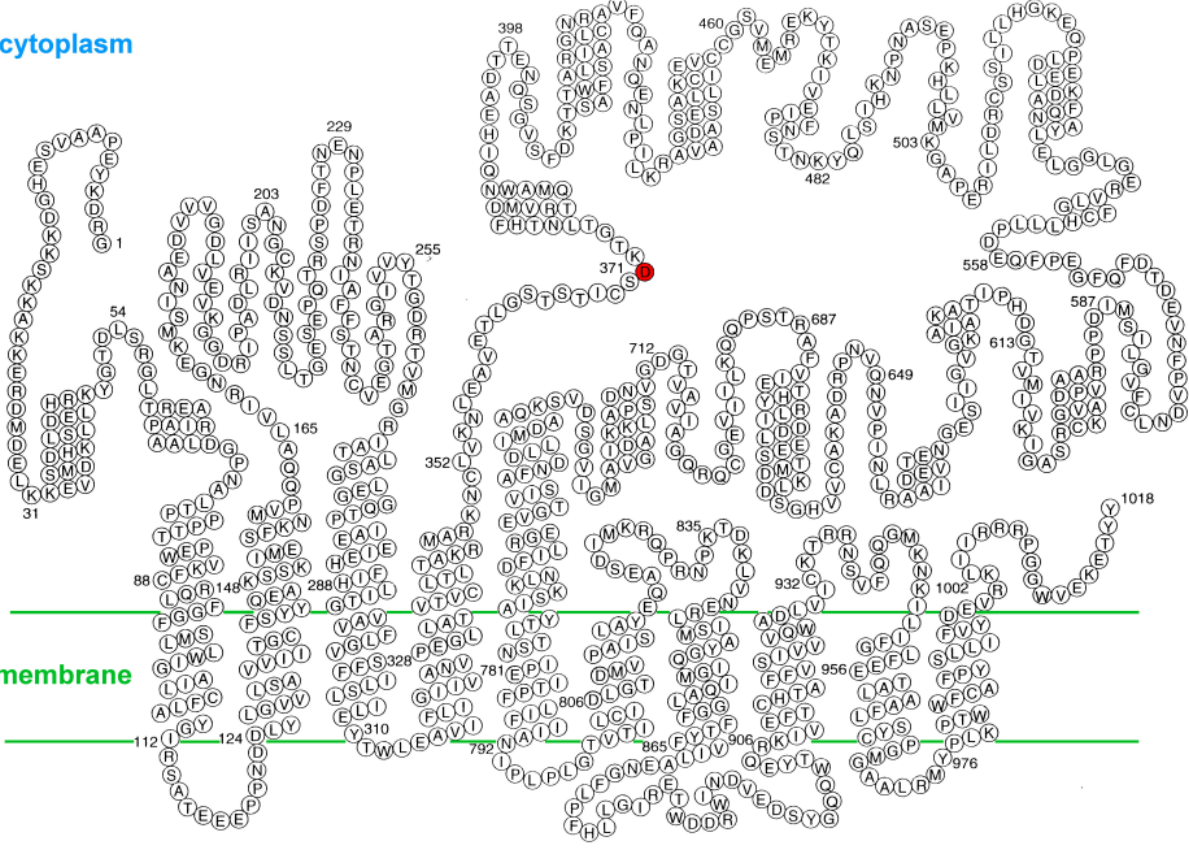
Figure 3. Secondary structure of the rat Na,K-ATPase α1 subunit with ten transmembrane helices. The high-lighted aspartate 371 is the amino acid phosphorylated by ATP. The drawing is adapted from Vilsen et al. 106 with